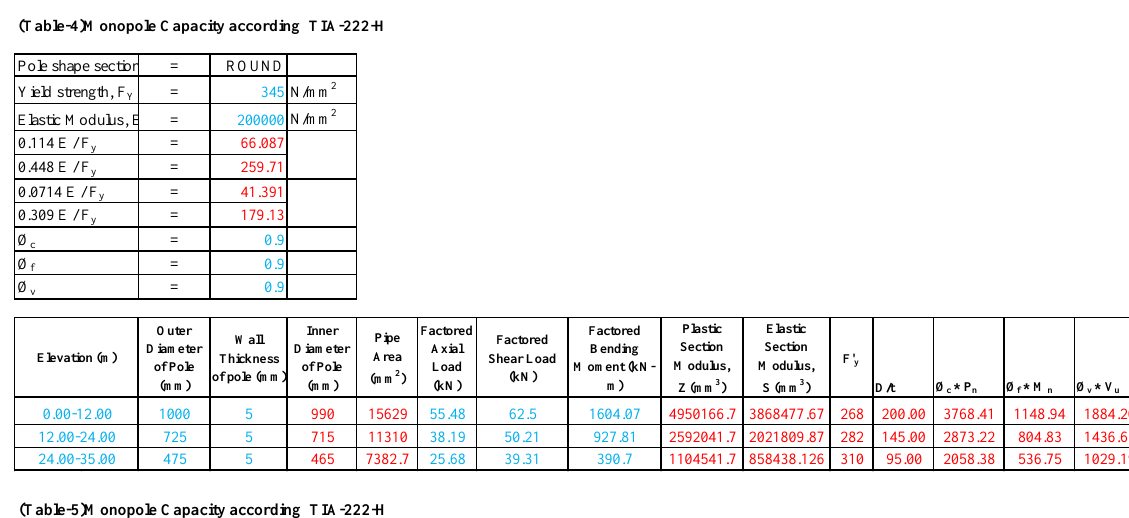
(Table-5)Monopole Capacity according